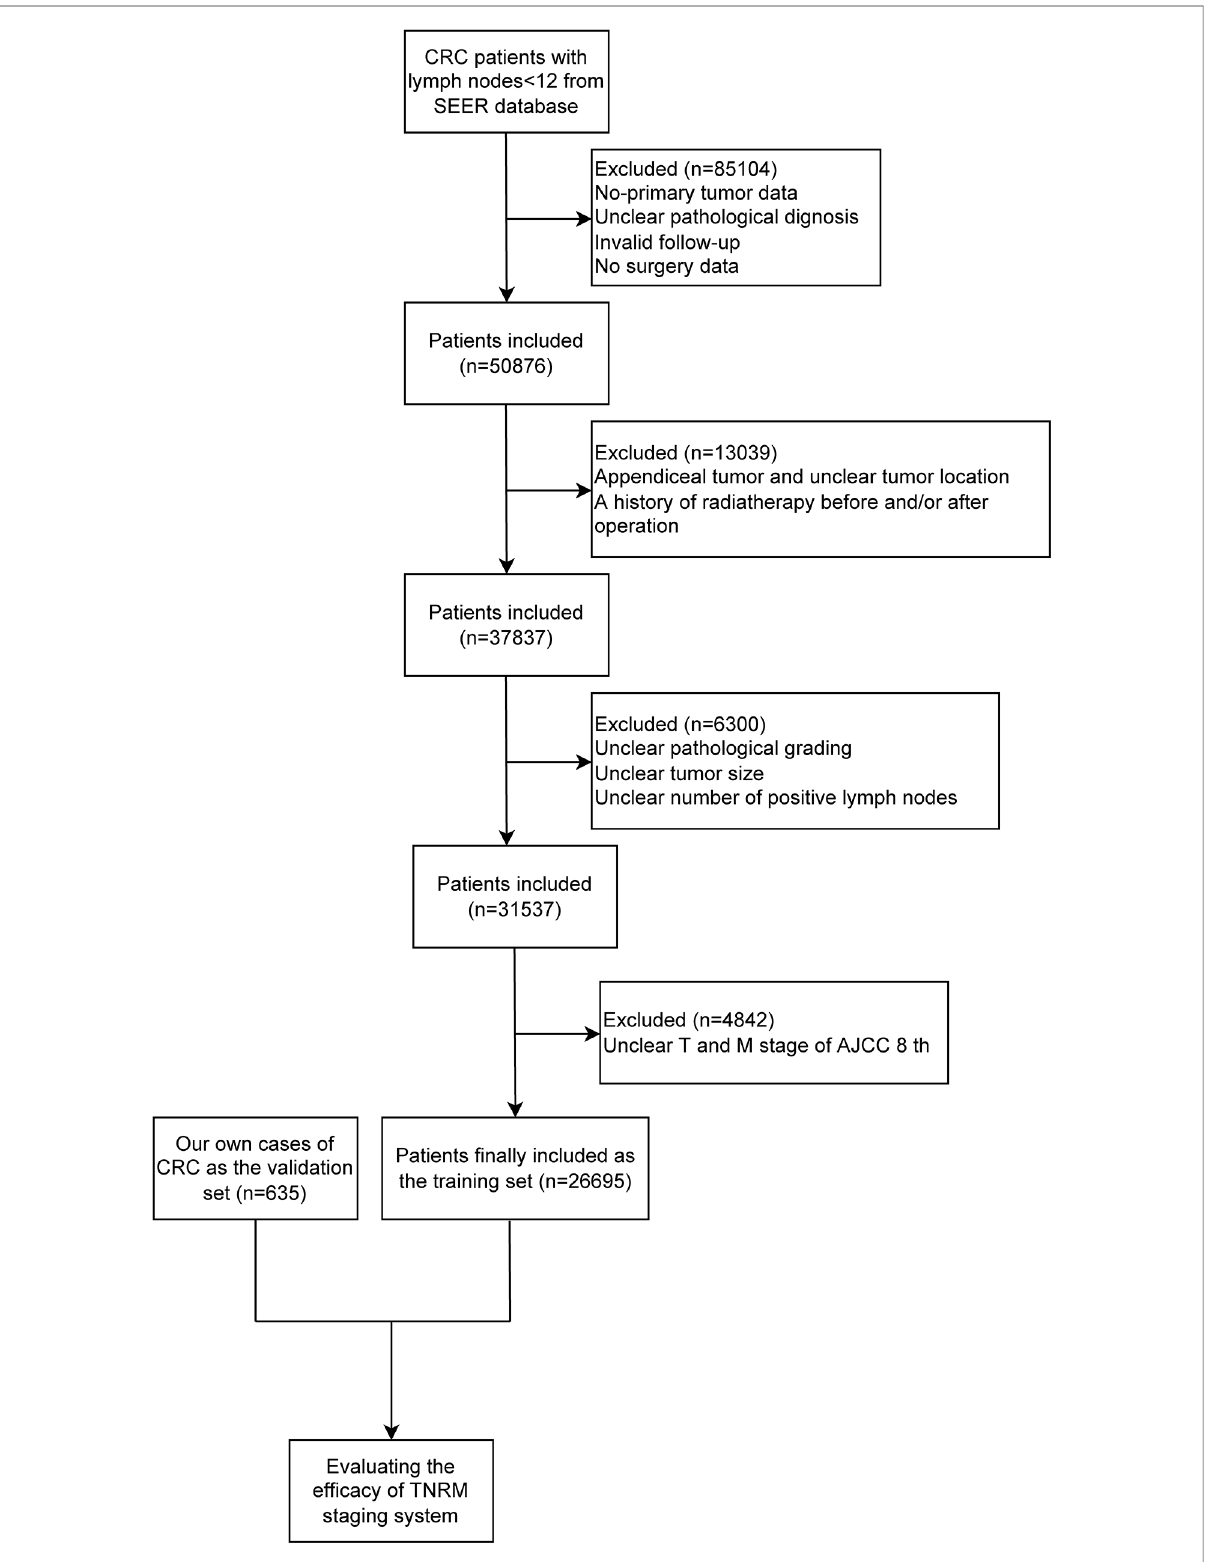
FIGURE 1 The screening process of the participants in this